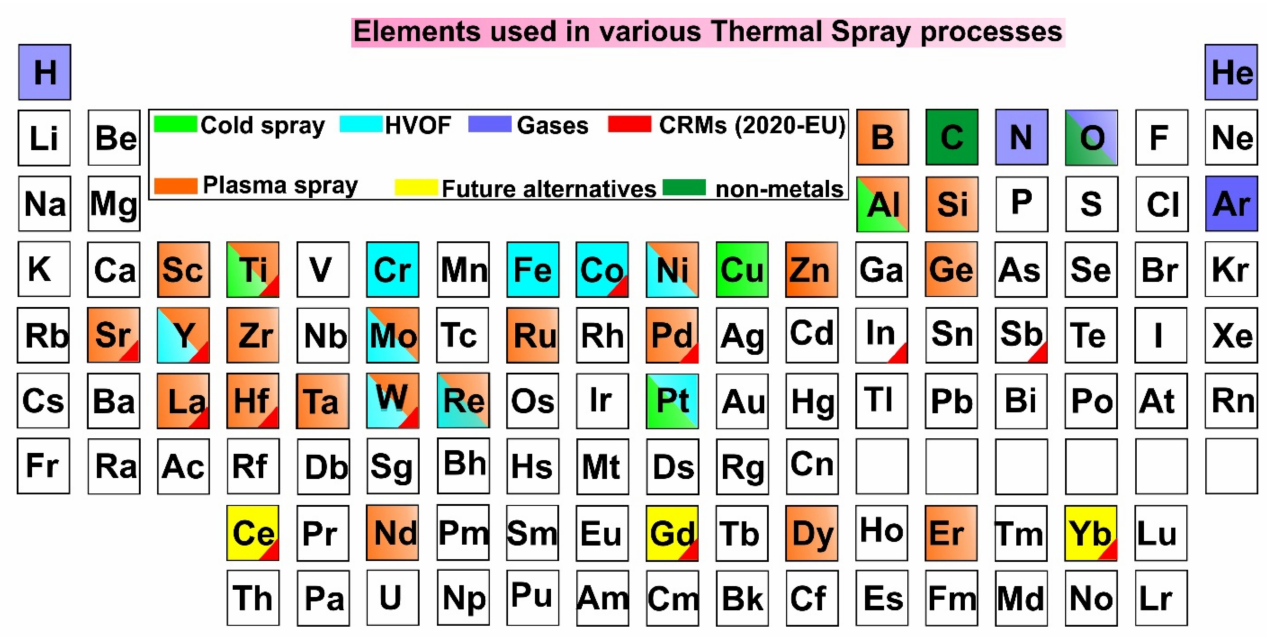
Figure 4. Elements in the periodic table that are typically preferred for different spraying routes. Uncoloured elements are those which are yet to find their space in the thermal spray ecosystem (author’s own